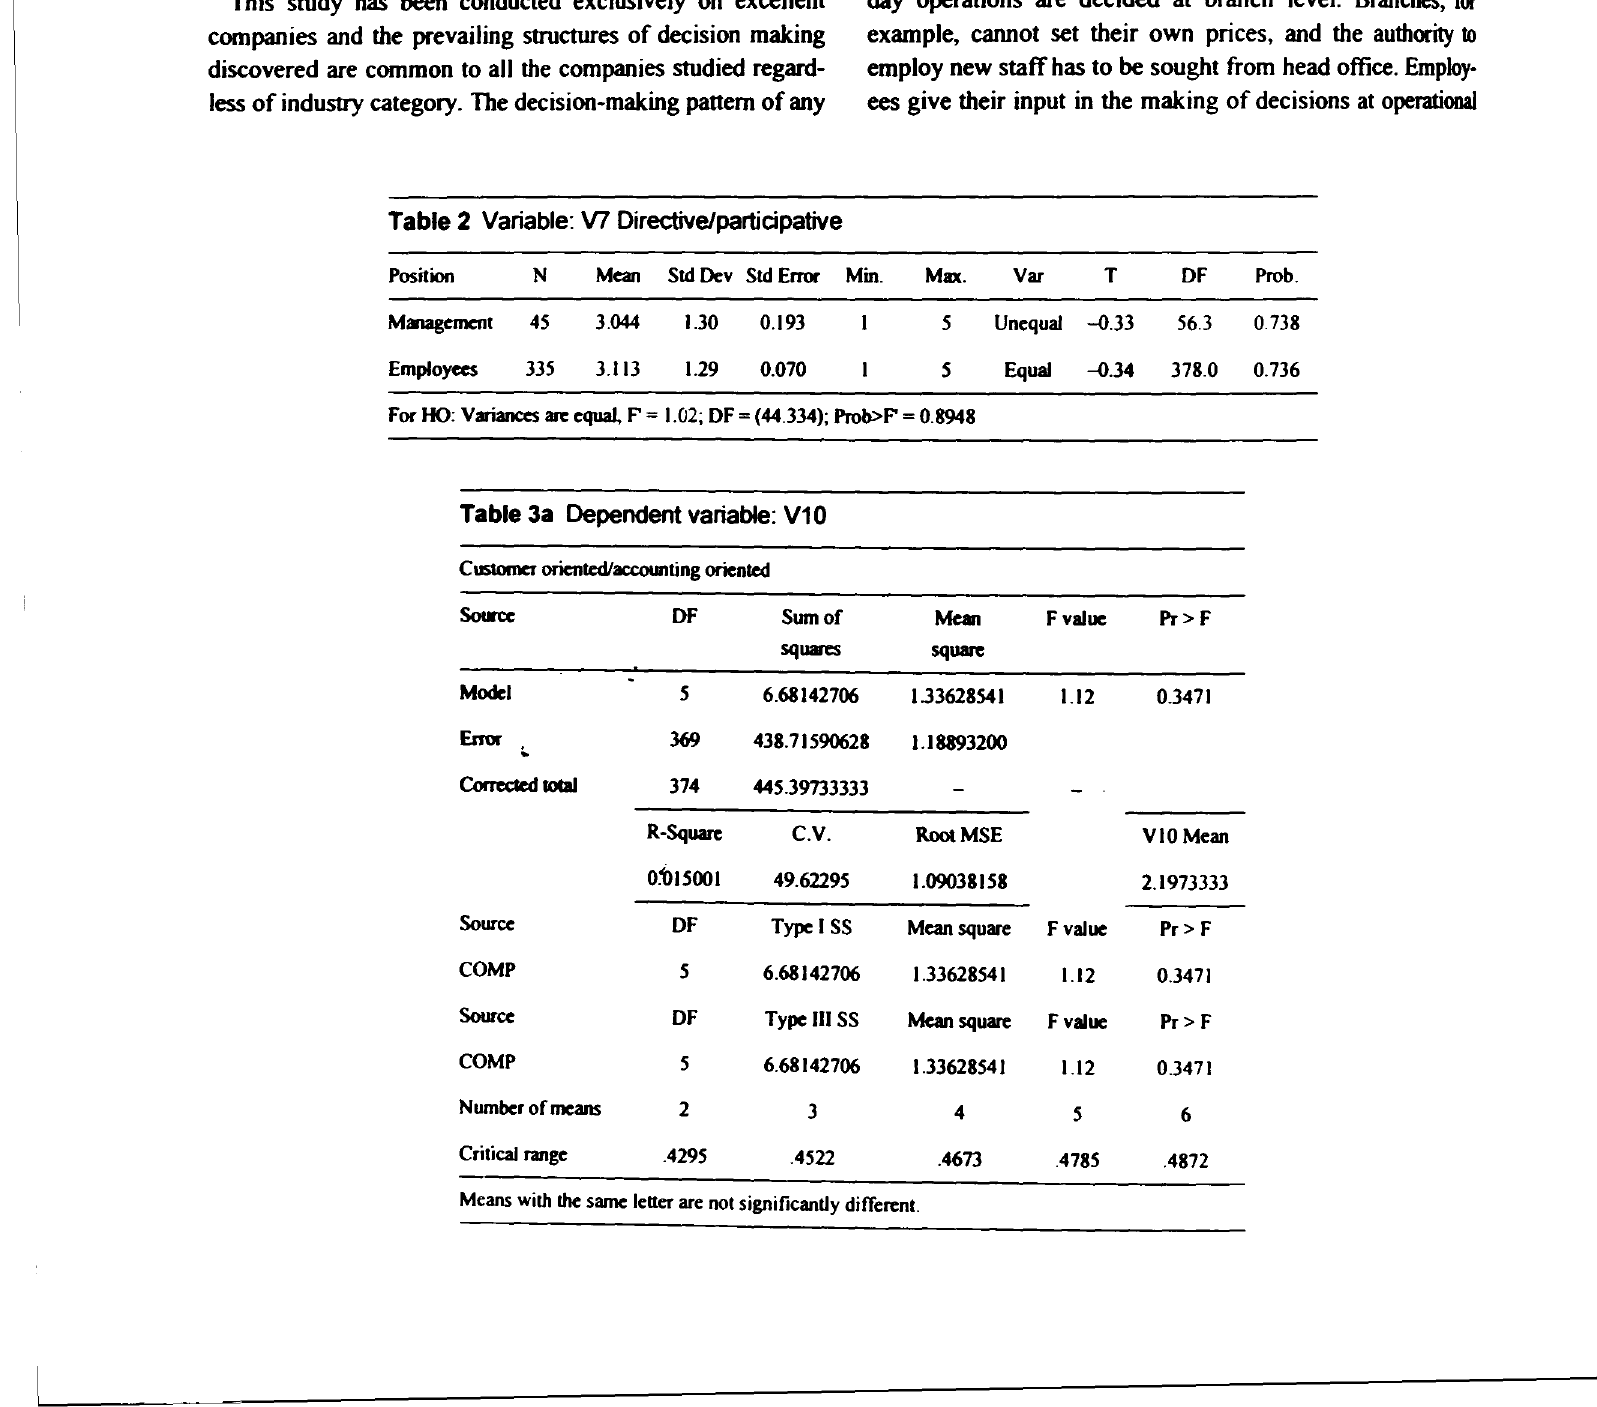
Table 3a Dependent variable: